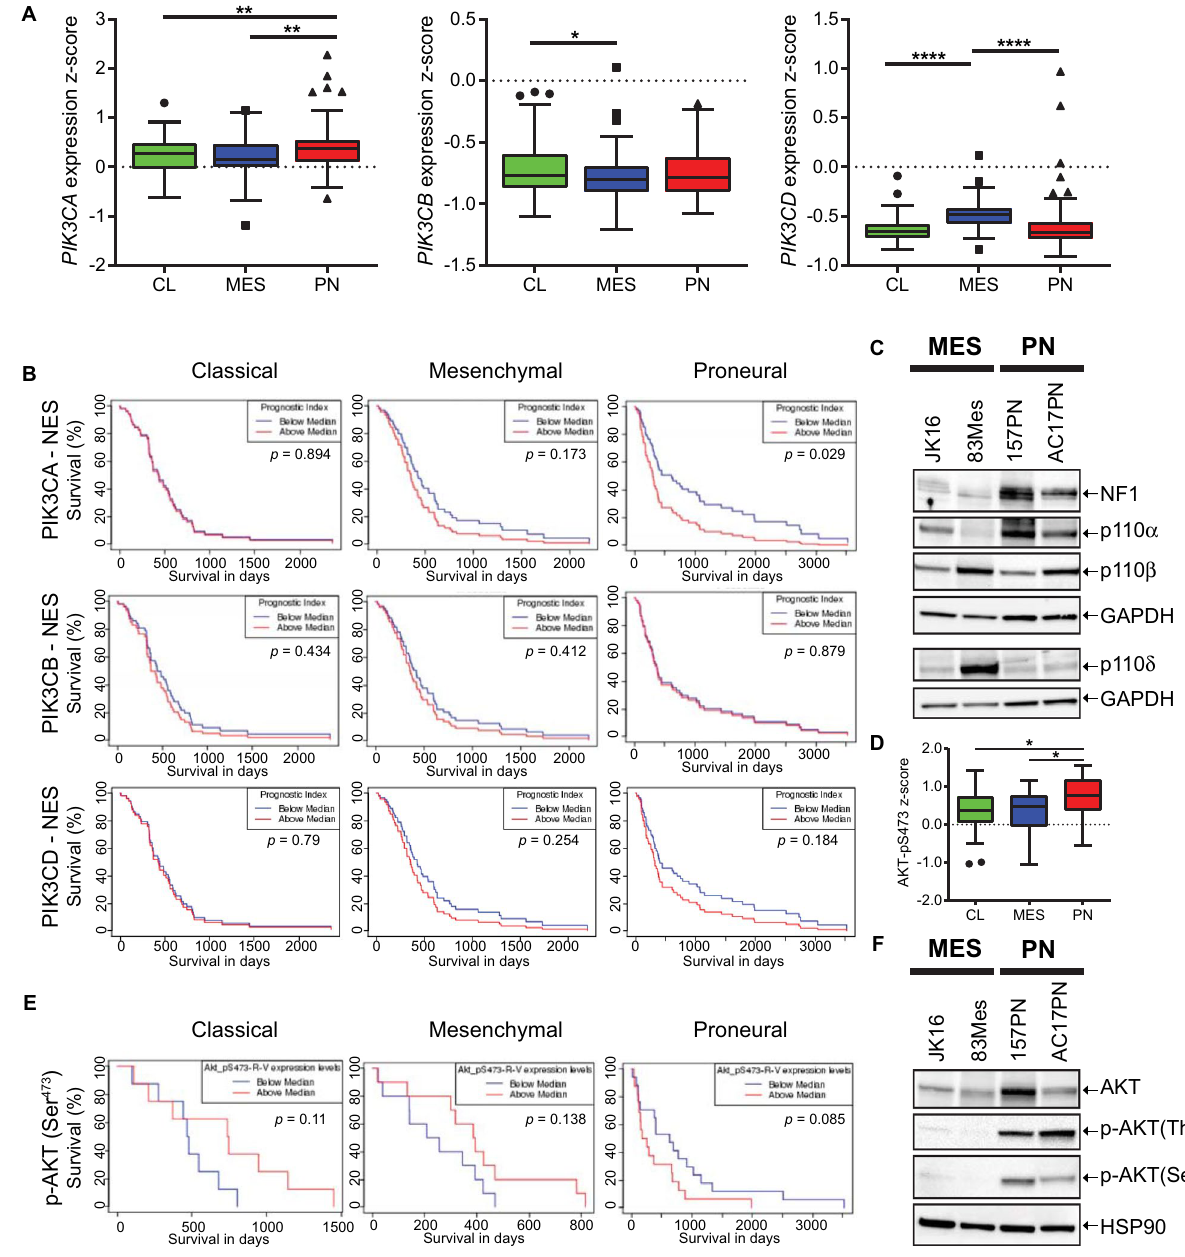
Figure 4. A discrete role for the alpha catalytic PI3K isoform in proneural (PN) GSCs. ( A ) Expression z-score data from TCGA (Extended Verhaak) for PIK3CA (left panel), PIK3CB (middle panel) and PIK3CD (right panel) were downloaded from the GBM- BioDP (http://gbm-biodp .nci.nih.gov/) for CL (n = 105), MES (n = 124) and PN (n = 113) subtype GBM from the HT Human Genome U133 (HT_HG-U133A) array and analysed using GraphPad Prism 8. As recent evidence suggests the neural subtype represents excessive contamination with normal brain, it has been excluded from the analysis. Unpaired one-way ANOVA, * p ≤ 0.05; ** p ≤ 0.01; **** p ≤ 0.0001. ( B ) Survival analysis based on the impact of the multi-gene prognostic index for coexpression of PIK3CA and NES (upper panels), PIK3CB and NES (middle panels) or PIK3CD and NES (lower panels) for CL (n = 53, left panels), MES (n = 57, middle panels) and PN (n = 56, right panels) subtype. TCGA gene expression data (Verhaak Core) for PIK3CA and NES , PIK3CB and NES or PIK3CD and NES from the HT_HG-U133A array were used for multigene prognostic index. Figure was generated using the GBM- BioDP software. ( C ) GSC lines JK16, 83Mes, 157PN and AC17PN were analysed by Western blot using antibodies against NF1, p110α and GAPDH. Membrane was stripped and reprobed with an antibody against p110β. Lysates from the same experiment were run in δ parallel and probed for p110 and GAPDH. ( D ) Reverse-phase protein microarray (RPPA) data from TCGA GBM samples. Boxplots of RPPA analytes for phospho-AKT(Ser 473 ) measured in CL (n = 28), MES (n = 29) and PN (n = 41) samples from the cohort of GBM tumours (Extended Verhaak) that was subjected to RPPA analysis within the TCGA consortium. RPPA data were downloaded from the GBM-BioDP and analysed using GraphPad Prism 8. Unpaired one-way ANOVA: * p ≤ 0.05. ( E ) Survival analysis based on RPPA analysis for phospho-AKT(Ser 473 ) using the Extended Verhaak cohort submitted to the TCGA consortium for CL (n = 28, left panel), MES (n = 29, middle panel) and PN (n = 41, right panel) subtypes. Figure was generated using the GBM-BioDP software. ( F ) GSC lines JK16, 83Mes, 157PN and AC17PN were analysed by Western blot using antibodies against AKT. Membrane was stripped and re-probed for p-AKT(Thr 308 ), then stripped and reprobed for p-AKT(Ser 473 ), then stripped and re-probed for